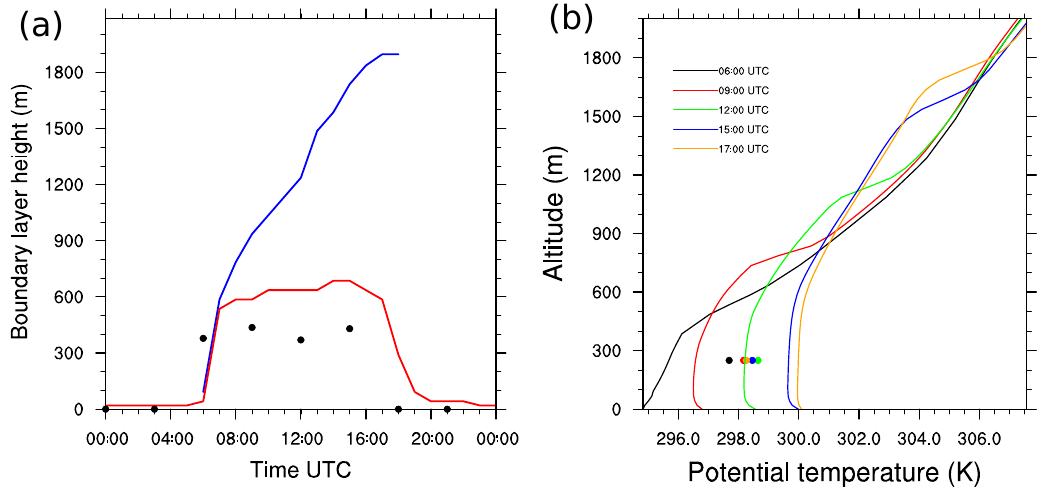
Figure 1. (a) Boundary layer height diurnal evolution computed from the bulk-Richardson method (red), the tracer method (blue) and composite values of boundary layer height for the SOP-2 period (1 August 2006–15 August 2006) based on Gounou et al. (2012) (black dots). (b) Potential vertical temperature profiles at 06:00 (black), 10:00 (red), 14:00 (green) and 17:00UTC